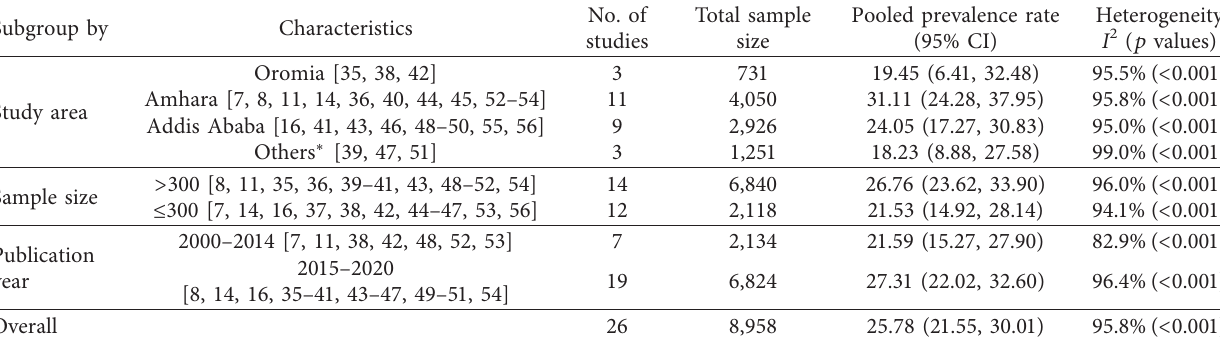
Table 3: Subgroup pooled prevalence analysis of bacterial isolates among patients suspected of bloodstream infection in Ethiopia, 2020. Subgroup by